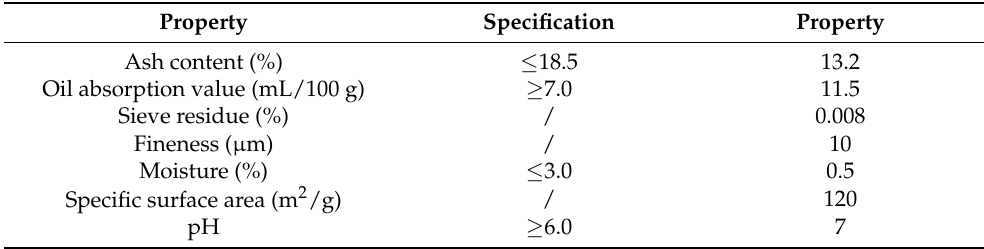
Table 2. Carbon black test results.